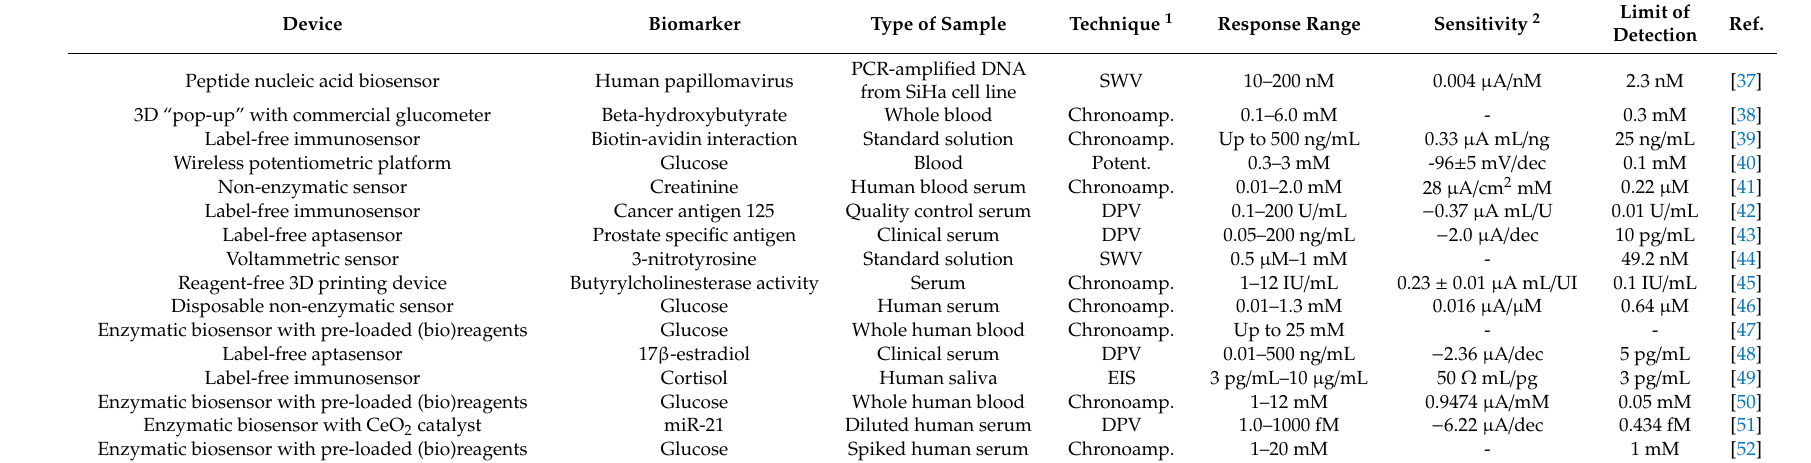
Table 2. Other relevant PADs with integrated electrochemical cell published between 2015 and